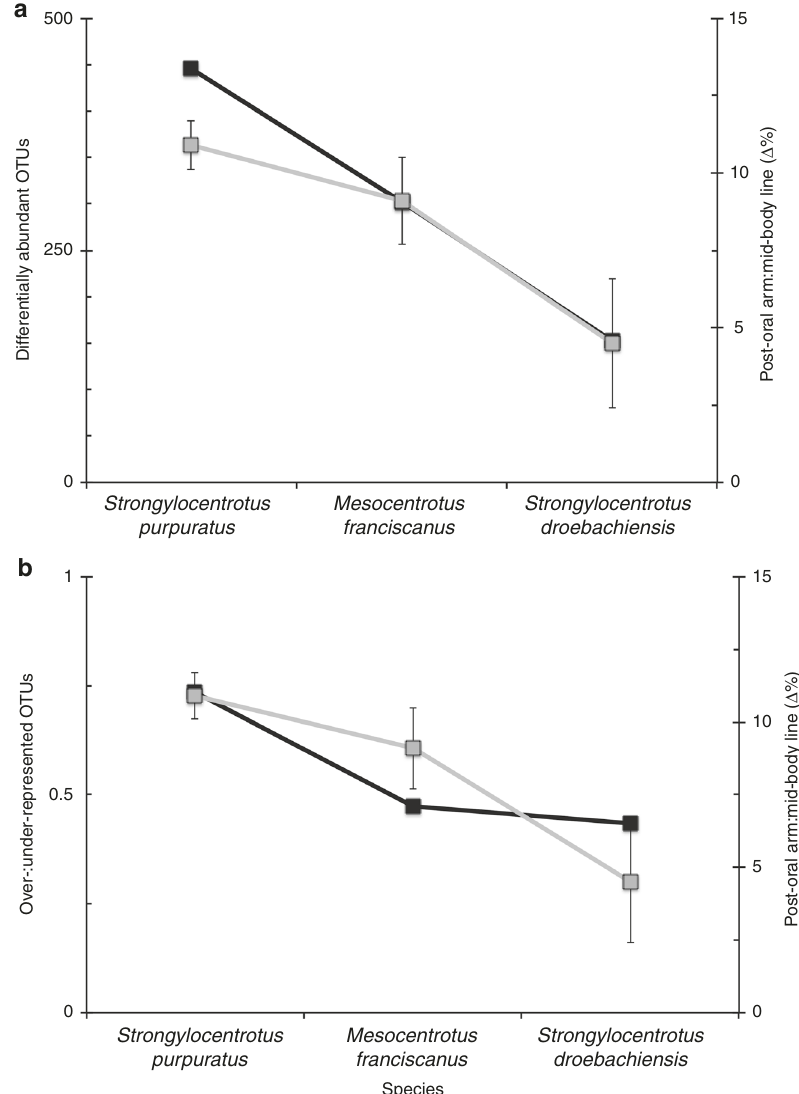
Fig. 3 Differential abundance of OTUs along a morphological continuum for three species of echinoid larvae. Total ( a ) and ratio of ( b ) over- and under- represented OTUs associated with Strongylocentrotus purpuratus , Mesocentrotus franciscanus , and S. droebachiensis larvae following the expression of phenotypic plasticity (black) and in relation to the change in larval morphology (gray). Species on the x axis are organized from least to most maternal investment, a direct correlate of the expression of phenotypic